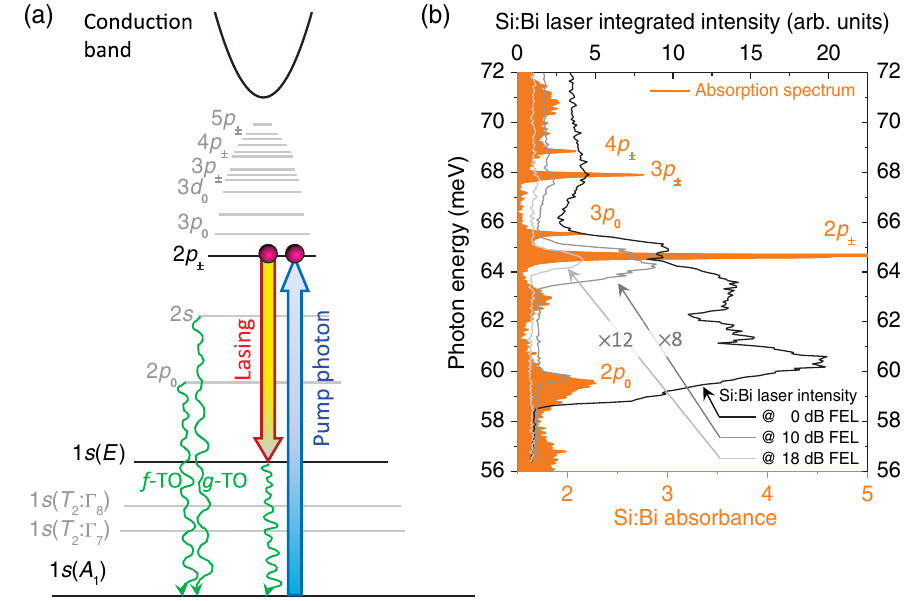
FIG. 2. (a) Si ∶ Bi laser scheme under resonant pumping in the upper laser level. Labels are the ground and excited states of a Bi center. Bold straight arrows indicate optical pump and lasing transitions, wavy arrows show nonradiative phonon-assisted relaxations. Note that energy spacings below the 2 p 0 state are for clarity not to scale. (b) Integrated intensity of the Si ∶ Bi laser as a function of the pump photon energy (spectral resolution: 0 . 05 μ m). The laser spectra were measured at different FEL power (the attenuation from maximum FEL power is given in the legend). For comparison the Si ∶ Bi absorption spectrum measured with a spectral resolution of 0 . 1 cm − 1 ( 12 . 5 μ eV) is plotted as well. Note that at lower pump intensities the integrated intensity is resolved into a discrete spectrum which is similar to the impurity absorption